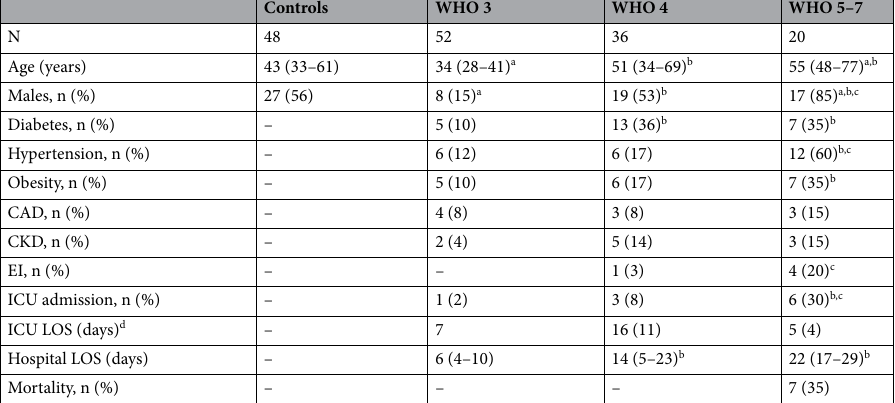
Table 1. Demographic and clinical data of controls and COVID-19 patients with different severity according to worst WHO stage. Continuous data are reported as median and interquartile range. Categorical data are reported as frequency and percentage. a p < 0.01, versus controls; b p < 0.01, versus WHO 3; c p < 0.01, versus WHO 4; d data are reported as average (standard deviation). CAD coronary artery disease, CKD chronic kidney disease, EI endotracheal intubation, ICU intensive care unit, LOS length of